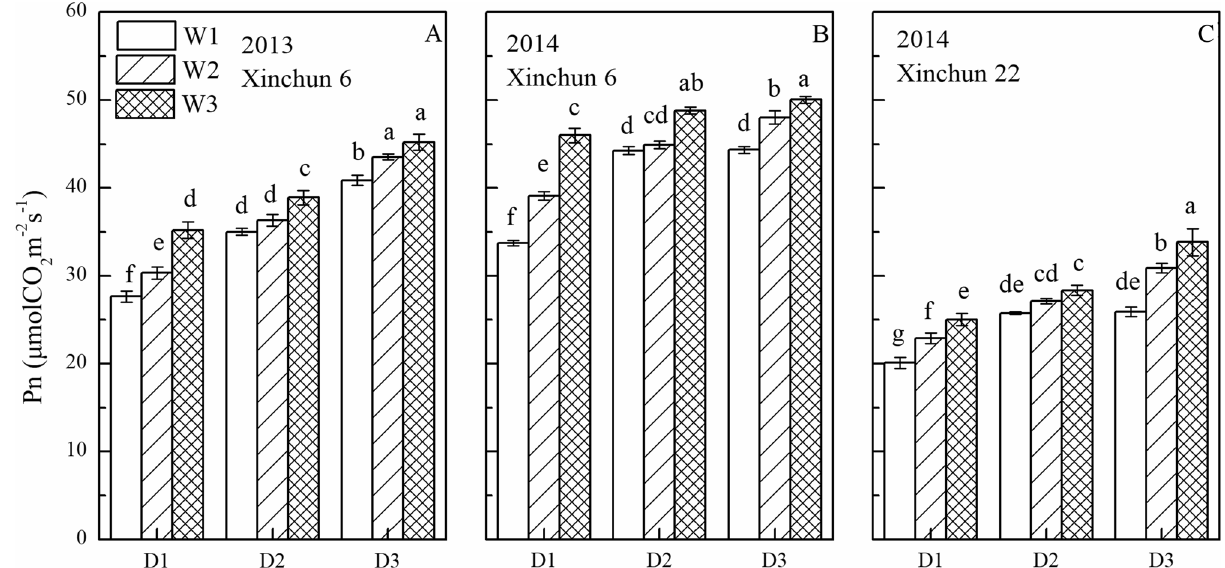
Figure 7. Leaf net photosynthetic rate (Pn) at early grain filling stage as affected by irrigation frequency and amount. ( A ) Pn of Xinchun 6 in 2013. ( B ) Pn of Xinchun 6 in 2014. ( C ) Pn of Xinchun 22 in 2014. Leaf Pn was calculated across five replicates for each day and then averaged for three days. Error bars represent ± SE (n = 10). Bars within a frame with a different letter are significantly different at P < 0.05.